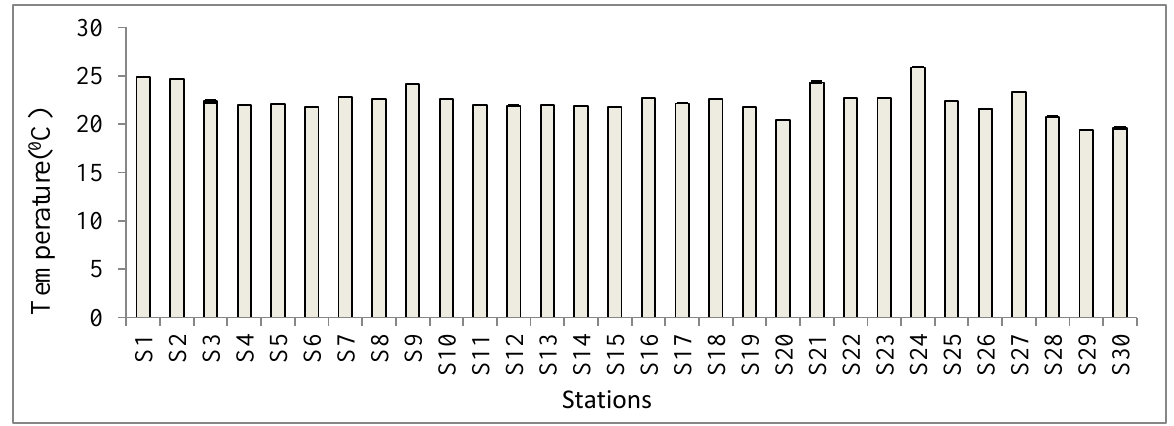
Figure 4. Cluster analysis based on Bray – Curtis similarity matrix of the most dominant 29 genera.